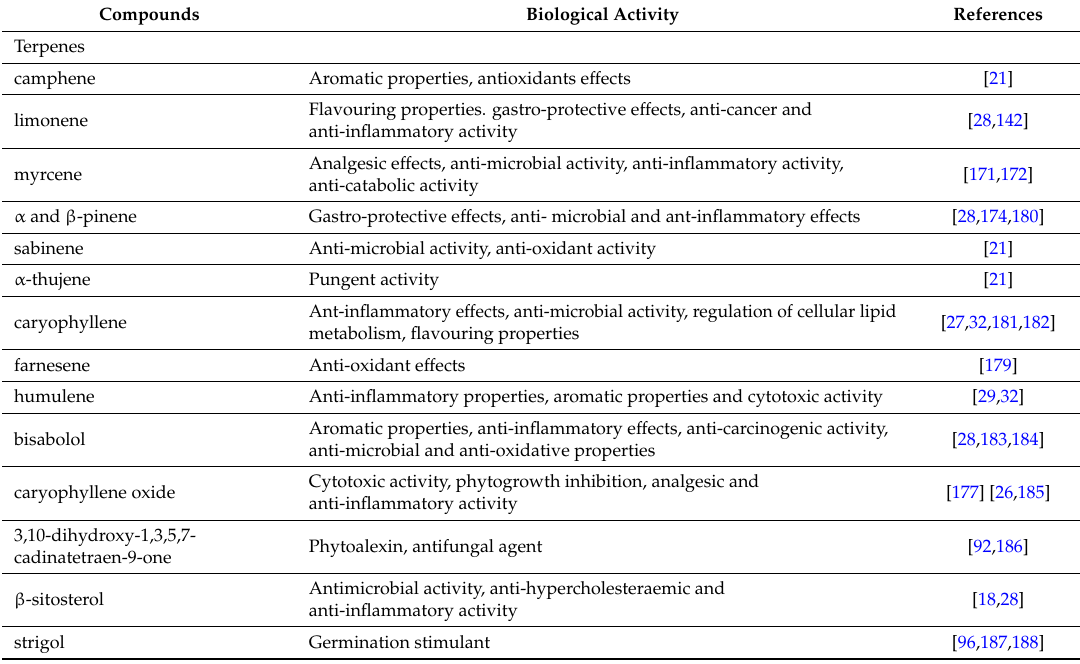
Table 2. Biological activities of different compounds present in